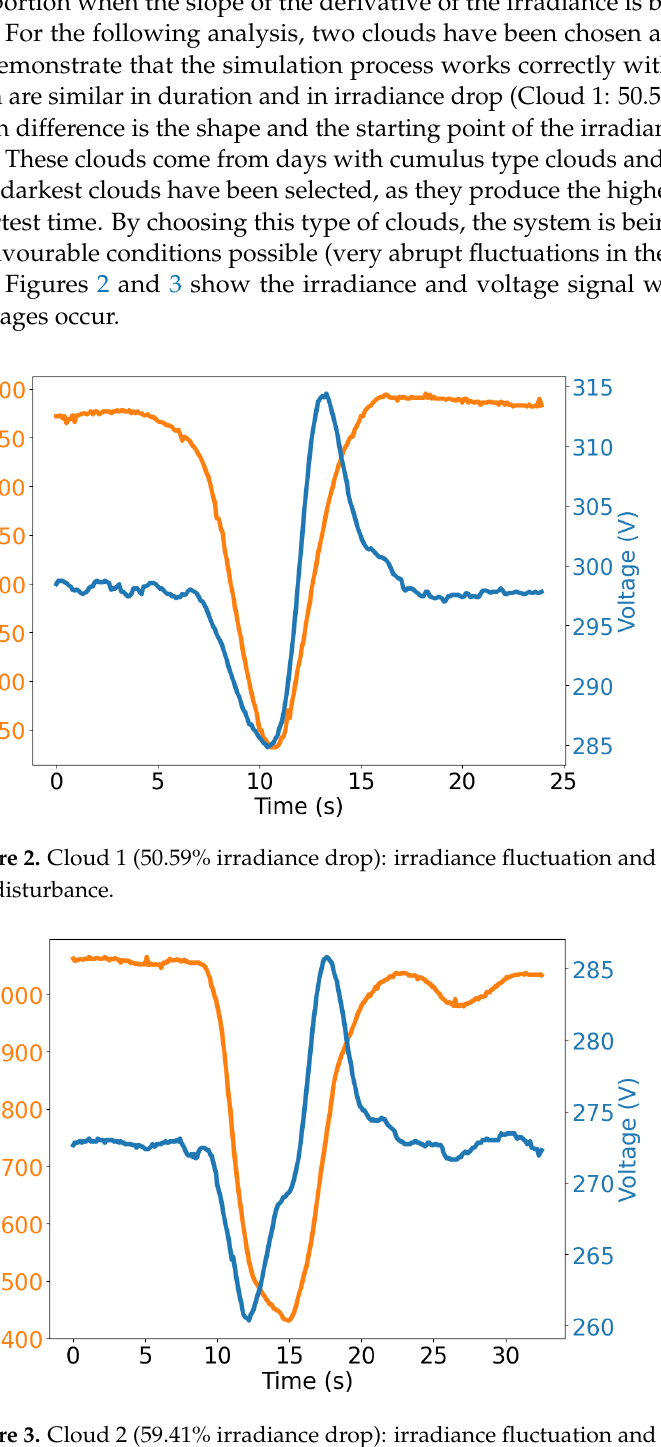
Figure 3. Cloud 2 (59.41% irradiance drop): irradiance fluctuation and corresponding system volt- age